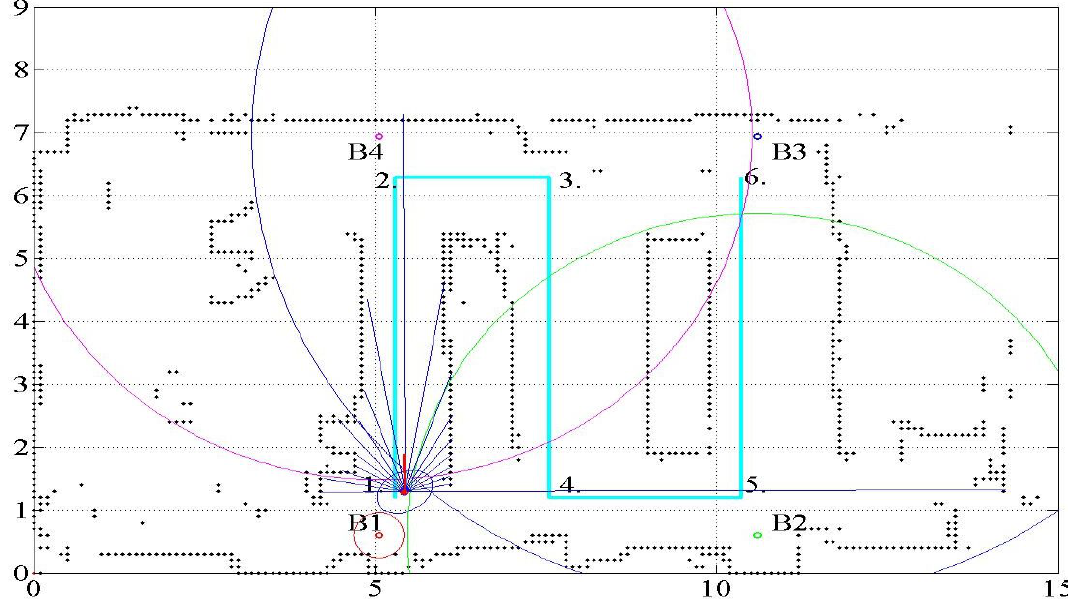
Figure 2. Work area and trajectory of the experiment. B,